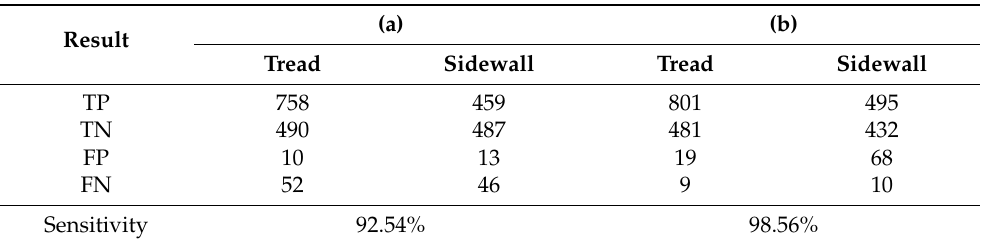
Table 7. Results Obtained by (a) the Modified YOLOv3 SPP Architecture, (b) the Incremental YOLOv3 SPP Architecture.